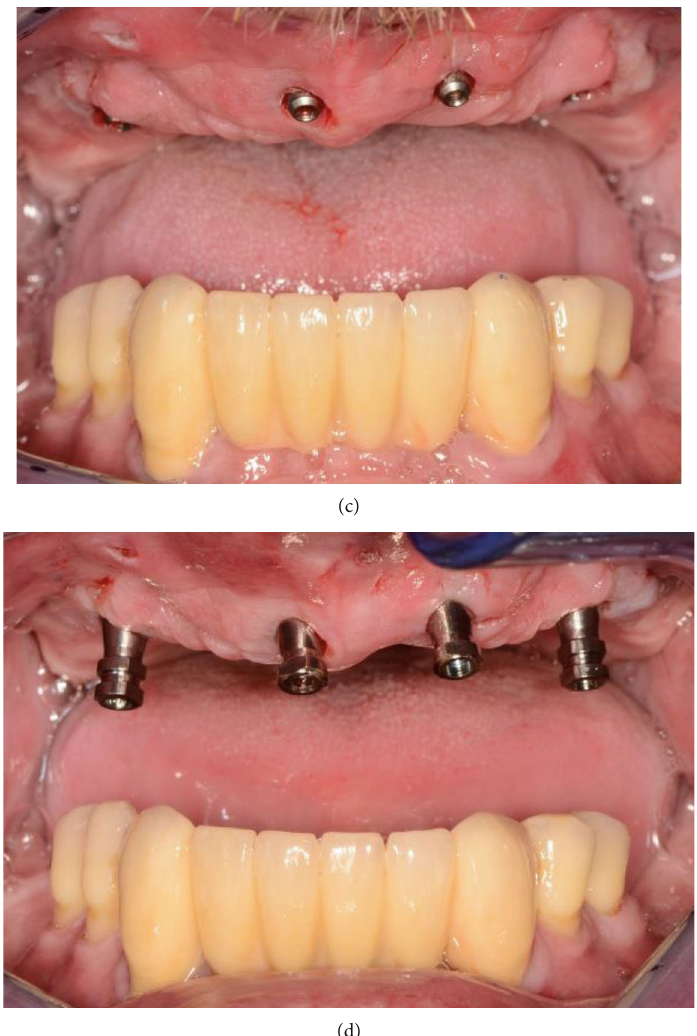
Figure 7: (a) Bar abutment with handle. (b) Inserted bar abutment. (c) Frontal view with inserted bar abutments. (d) Screwed-on adhesive